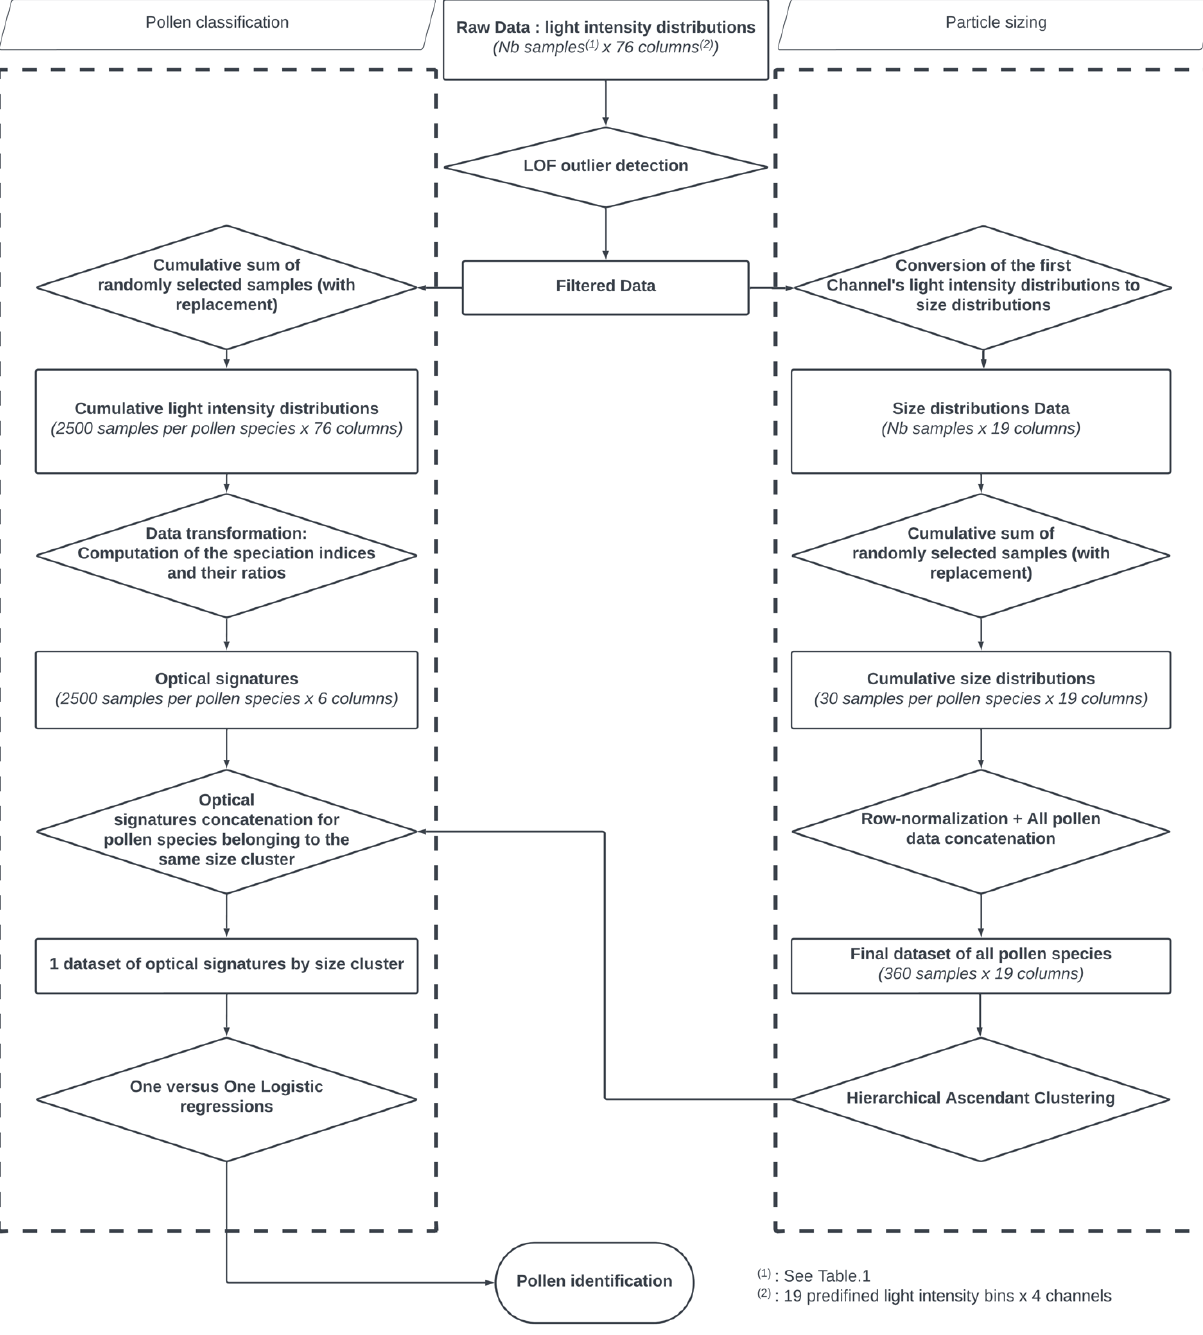
Figure 2. An outline of the proposed